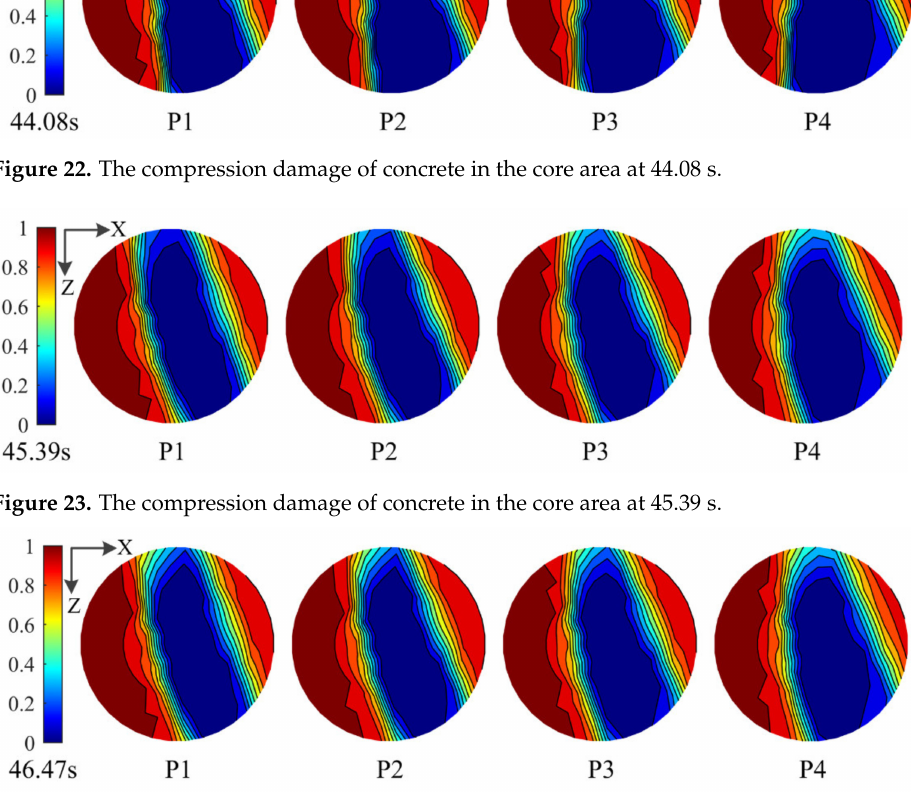
Figure 24. The compression damage of concrete in the core area at 46.47 s.